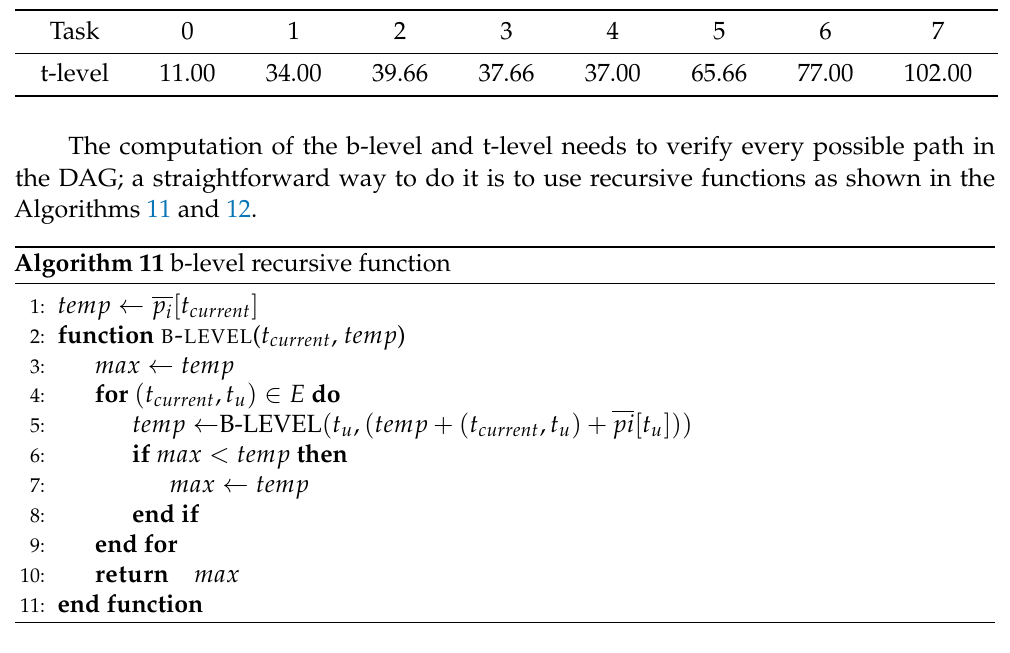
Table 10. t-level values for the DAG in Figure 1.